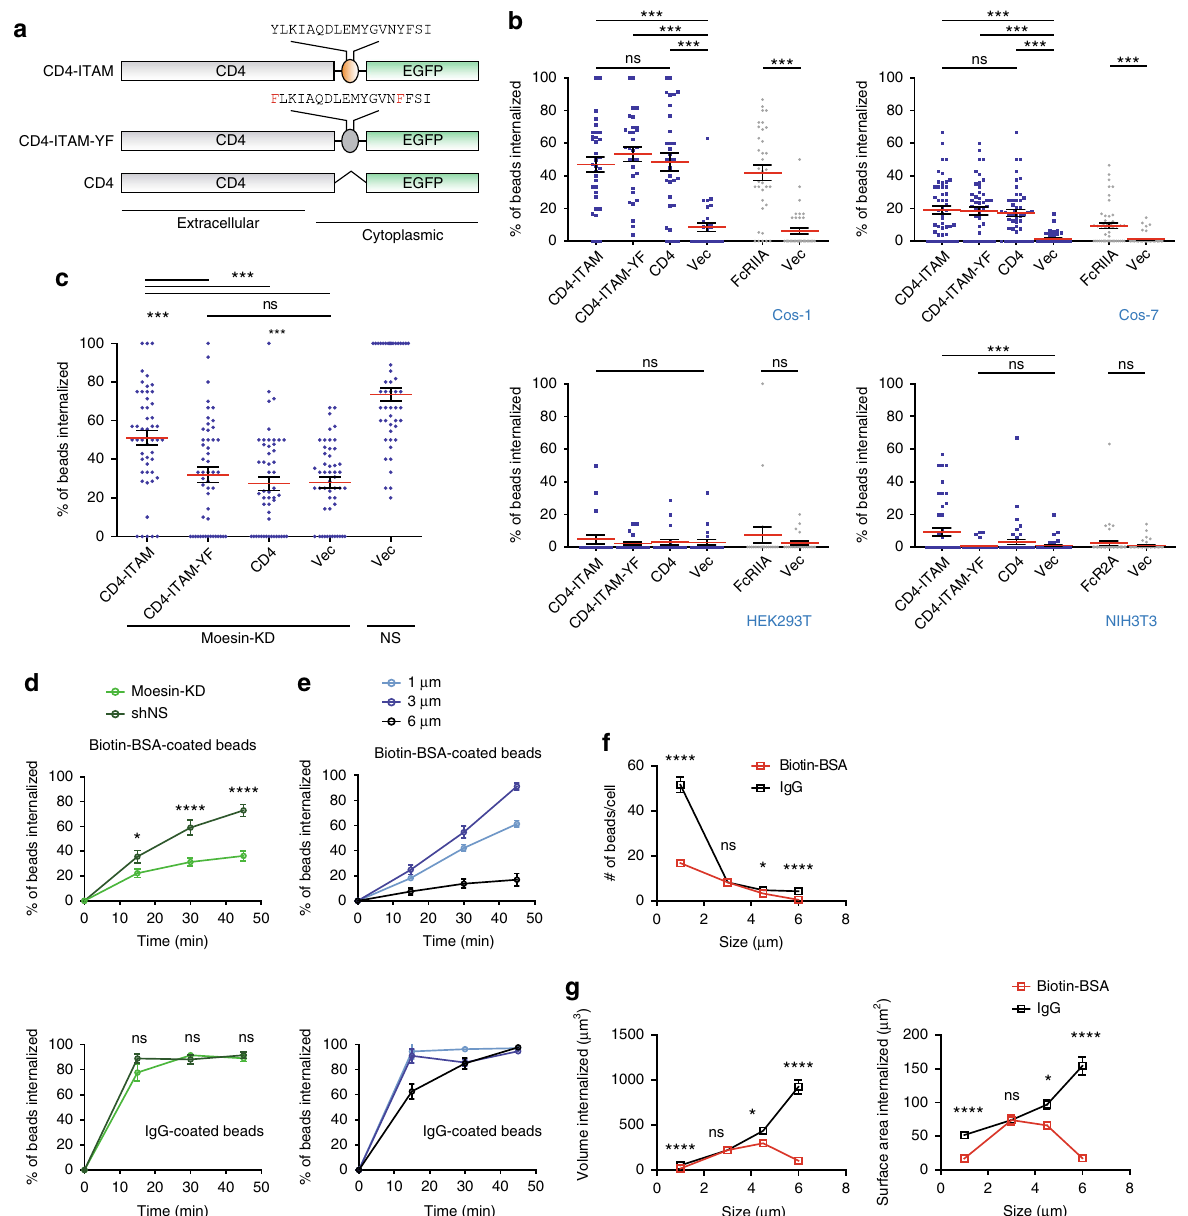
Fig. 5 PIP2-Moesin-Syk axis is qualitatively similar to but quantitatively less robust than FcR signaling. a Schematic of a series of CD4-EGFP chimeric sequences, with or without a WT or mutated ITAM. b Cos-1, Cos-7, HEK293T, and NIH3T3 cells were transfected with the chimeric molecules by transient overexpression. Empty vector control and FcRIIA for phagocytosis ef fi ciency control were also shown. *** p < 0.001 and ns p > 0.05 by one-way ANOVA with Scheffé post hoc. Phagocytosis ef fi ciency was measured with anti-CD4-coated or IgG-coated 3 µ m beads. n = 50, N = 3. c Identical to b except that Moesin KD DC2.4 cells were rescued with the constructs as shown in b . NS was used as a positive control to establish the full capacity of phagocytosis in DC2.4 cells without Moesin knockdown. n = 50, N = 3. *** p < 0.001 and ns p > 0.05 by one-way ANOVA with Scheffé post hoc. d Ef fi ciency of Moesin- dependent (top) and FcR-dependent (bottom) phagocytosis was measured with biotin-BSA-coated beads or IgG-coated beads in shMoesin or shNS treated DC2.4 cells. n = 50, N = 3. * p < 0.5, **** p < 0.0011 and ns p > 0.05 by one-way ANOVA with Scheffé post hoc. e Impact of particle size on the ef fi ciency of Moesin-dependent and FcR-dependent phagocytosis was measured as per phagocytosis assay with 1, 3, or 6 μ m biotin-BSA-coated beads (upper) or IgG-coated beads (lower) in RAW264.7 cells. n = 50, N = 4. f To investigate the effects of particle sizes on phagocytosis, phagocytosis assays were performed with 1, 3, 4.5, and 6 μ m biotin-BSA-coated (red line) or IgG-coated (black line) polystyrene beads on RAW264.7 cells. The numbers of beads internalized per cell on average were counted for each condition. n = 50, N = 4. * p < 0.05, **** p < 0.0001 and ns p > 0.05 by one-way ANOVA with Scheffé post hoc. g Volume and surface area internalized by RAW264.7 cells in f were calculated from the following formula. Volume = 4/3 π r 3 , and surface area = 4 π r 2 . * p < 0.5, **** p < 0.0011, and ns p > 0.05 by one-way ANOVA with Scheffé post